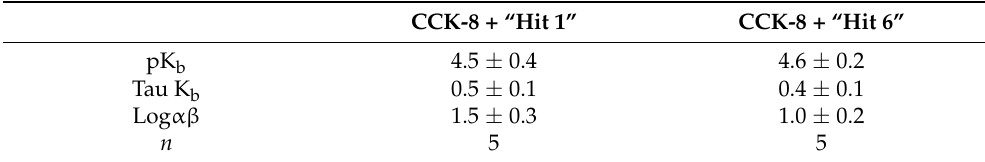
Figure 2. Positive allosteric modulation of CCK action at CCK1R expressed on CHO-CCK1R cells. Shown are the abilities of “hits” 1 and 6 utilized in 10 µ M concentrations to shift the CCK concentration–response curves to the left in a dose-dependent manner. Values were plotted as per- centages of maximal intracellular calcium responses to CCK in each replicate curve. There were no statistically significant differences in the maximal responses achieved under any condition. Data plotted represent means ± SEM and are analyzed in Table 3. Table 3. Cooperativity analysis of the impact of tetracyclic compounds on CCK-stimulated intracellu- lar calcium responses in CCK1R-expressing